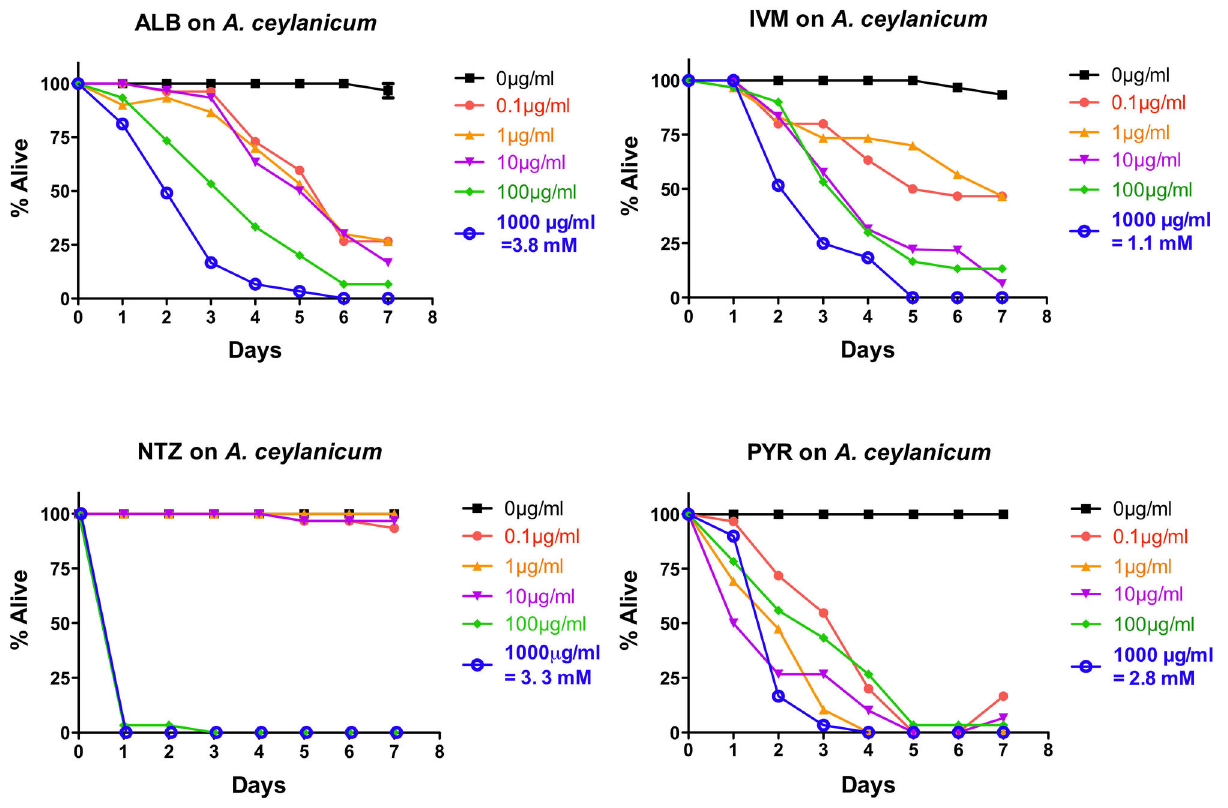
Figure 1. Intoxication of Ancylostoma ceylanicum adults in vitro using five doses of albendazole (ALB), ivermectin (IVM), nitazoxanide (NTZ), or pyrantel (PYR). For comparative reference, the molar concentration of each drug at 1000 µg/mL is indicated. Parasites were scored daily for motility. Any motility, including motility after prodding, was counted as “alive.” Lack of motility, including the lack of a response after prodding, was counted as “dead.” Data are the combination of three independent trials with 10